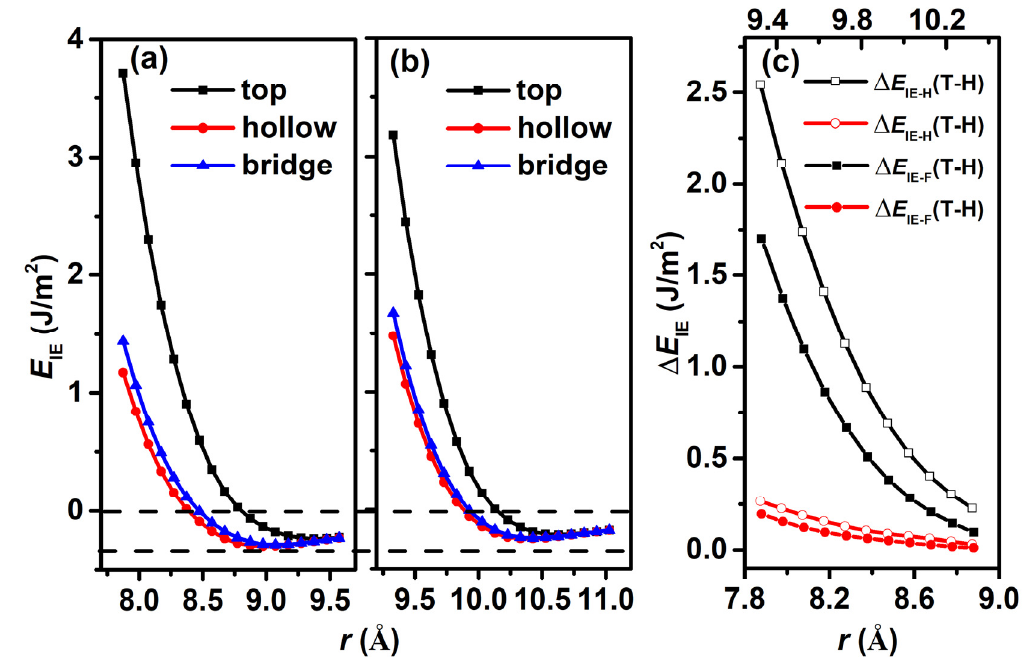
Figure 3. Interaction energy E IE as a function of interlayer space r between two sheets of ( a ) H-diam/H-diam and ( b ) F-diam/F-diam, respectively. ( c ) The difference in E IE between top and hollow stackings ( Δ E IE-H (T-H) for H-diam/H-diam, Δ E IE-F (T-H) for F-diam/F-diam), and between bridge and hollow stackings ( Δ E IE-H (B-H) for H-diam/H-diam, Δ E IE-F (B-H) for F-diam/F-diam) as a function of r in both systems.